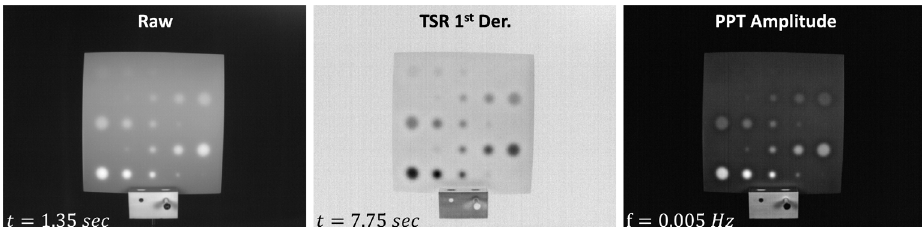
Figure 6. Comparison of raw and pre-processed thermograms, for the maximum absolute contrast frame.